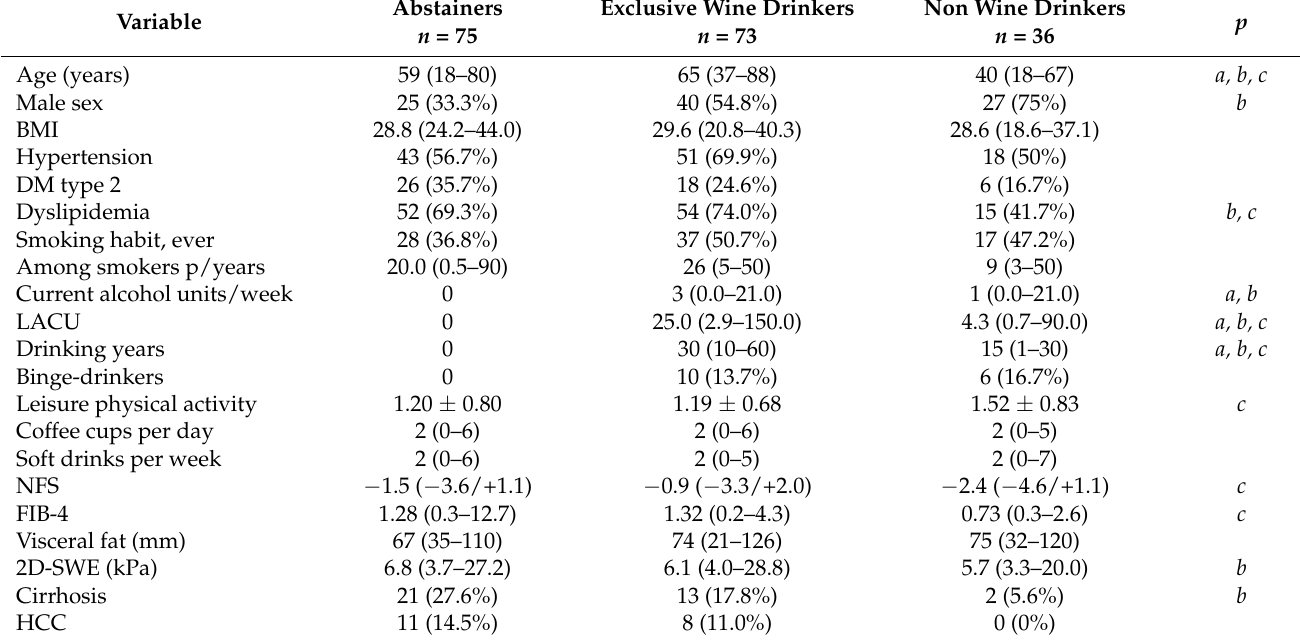
Table 4. Patients characteristics according to the kind of alcoholic beverages